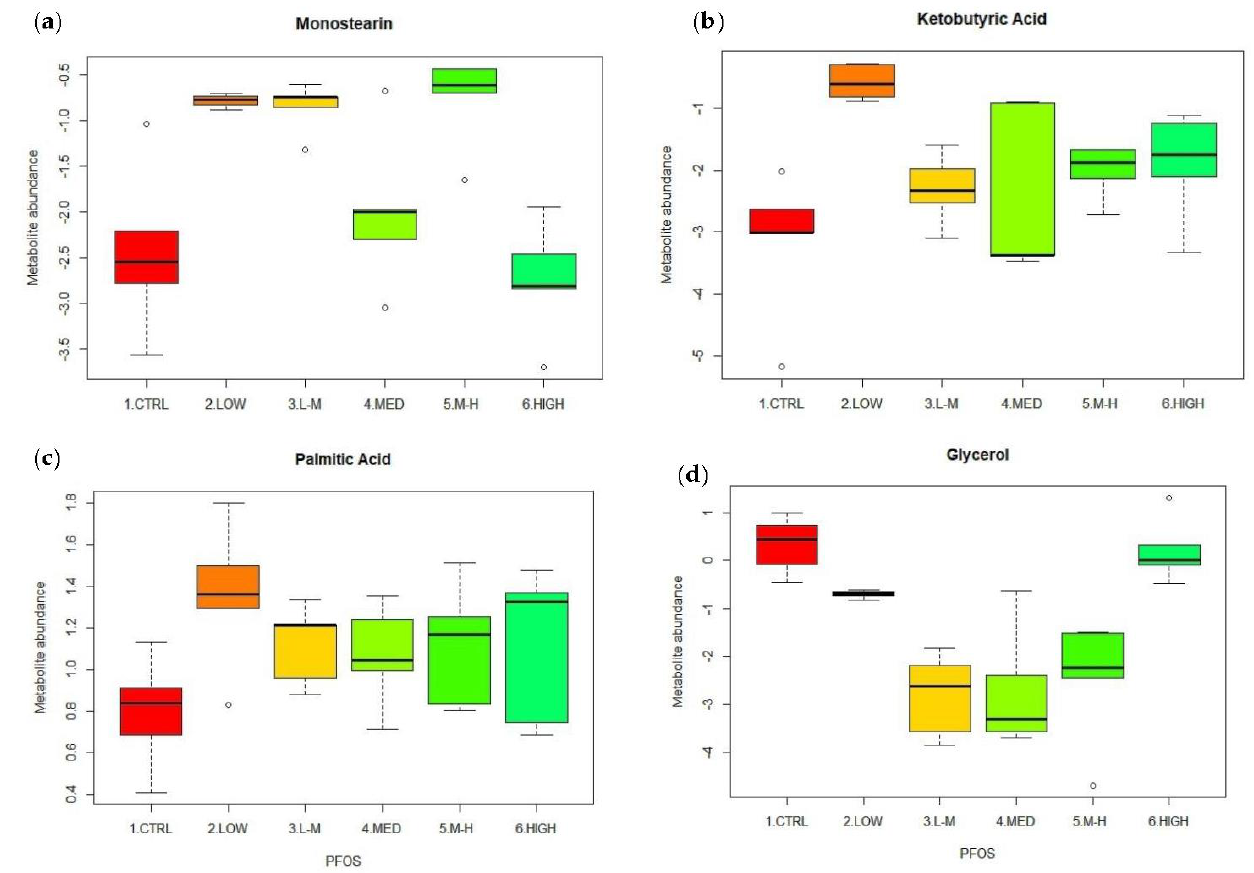
Figure 3. Top four significant metabolite features from amphipods when exposed to PFOS at low